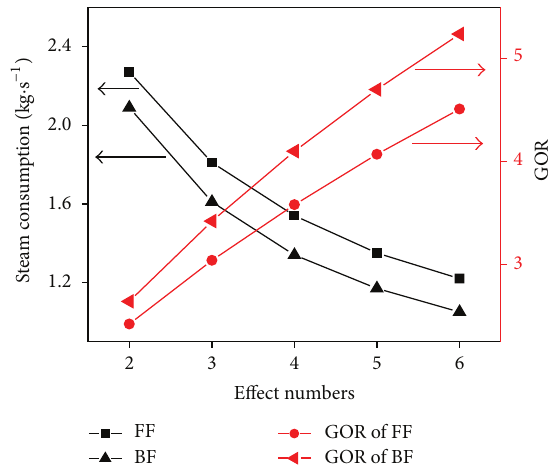
Figure 8: Comparison of steam consumption and GOR between FF system and BF